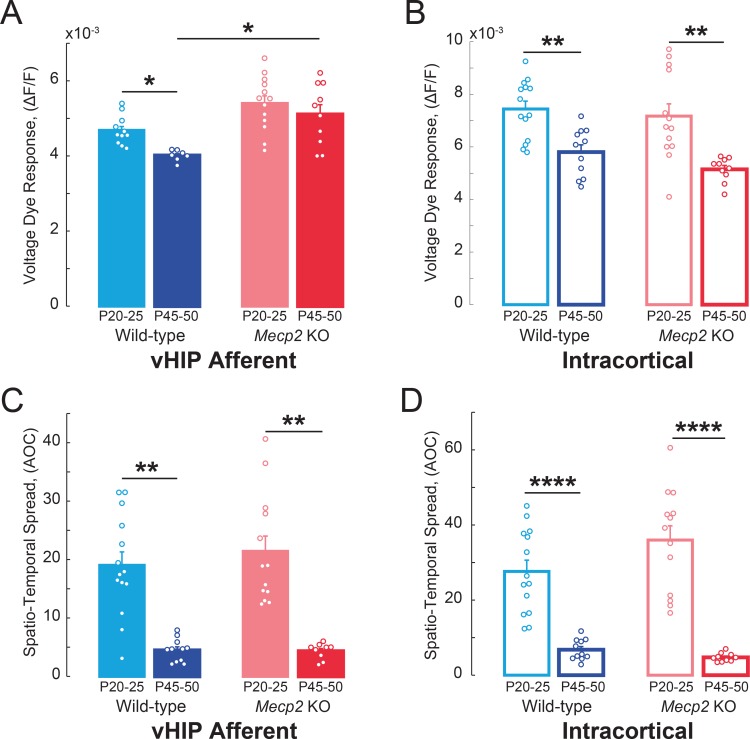
VSD responses to vHIP stimulation in mPFC slices of Mecp2 KO mice do not develop in a typical manner.(A–B) Peak VSD responses evoked by either (A) a single vHIP fiber stimulation or (B) a single intracortical stimulation in mPFC slices from WT and Mecp2 KO mice at P20-25 and P45-50 (WT young vs.WT adult vHIP p=0.0151; WT young vs. Mecp2 KO young vHIP p=0.4678; Mecp2 KO young vs. Mecp2 KO adult vHIP p=0.4678; WT adult vs. Mecp2 KO adult vHIP p=0.0157; Interaction p=0.1166; Age p=0.0061; Genotype p=0.0099; Two-Way ANOVA with Benjamini and Hochberg Multiple Comparisons; WT young vs. WT adult intracortical p=0.0020; WT young vs. Mecp2 KO young intracortical p=0.4145; Mecp2 KO young vs. Mecp2 KO adult intracortical p=0.0018; WT adult vs. Mecp2 KO adult intracortical p=0.3699; Interaction p=0.8253; Age p<0.0001; Genotype p=0.1946; Two-Way ANOVA with Benjamini and Hochberg Multiple Comparisons). (C–D) Spatiotemporal spread of VSD signals evoked by (C) vHIP afferent stimulation or (D) intracortical stimulation in mPFC slices from WT and Mecp2 KO mice at P20-25 and P45-50 (WT young vs. WT adult vHIP p<0.0001; WT young vs. Mecp2 KO young vHIP, p=0.9532; Mecp2 KO young vs. Mecp2 KO adult vHIP, p<0.001; WT adult vs. Mecp2 KO adult vHIP, p=0.9532; Interaction p=0.9336; Age p<0.0001; Genotype p=0.8700; Two-Way ANOVA with Benjamini and Hochberg Multiple Comparisons; WT young vs. WT adult intracortical, p<0.0001; WT young vs. Mecp2 KO young intracortical, p=0.2549; Mecp2 KO young vs. Mecp2 KO adult intracortical p<0.0001; WT adult vs. Mecp2 KO adult intracortical, p=0.6539; Interaction p=0.2358; Age p<0.0001; Genotype p=0.5842; Two-Way ANOVA with Benjamini and Hochberg Multiple Comparisons) (n = 14 slices from 5 P20-25 WT mice; n = 18/5 P20-25 Mecp2 KO, n = 11/7 P45-55 WT mice, n = 11/5 P45-55 Mecp2 KO mice; Spatiotemporal spread = AOC created by spread of the cortical area (% of total) and time (ms). Mean ± SEM; *p<0.05, **p<0.01.10.7554/eLife.44182.022Figure 4—figure supplement 3—source data 1.Lack of effects of long-term DREADD stimulation by CNO on anxiety and general (non-social memory) behaviors.